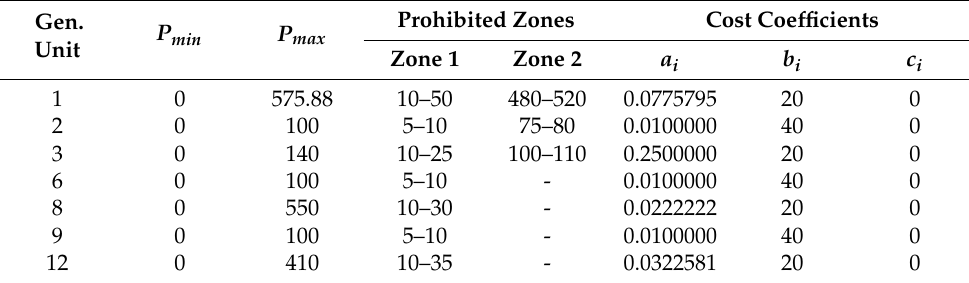
Table 9. Cost coefficients and generating unit limits for the ED problem with the prohibited operating zones (IEEE 57-Bus